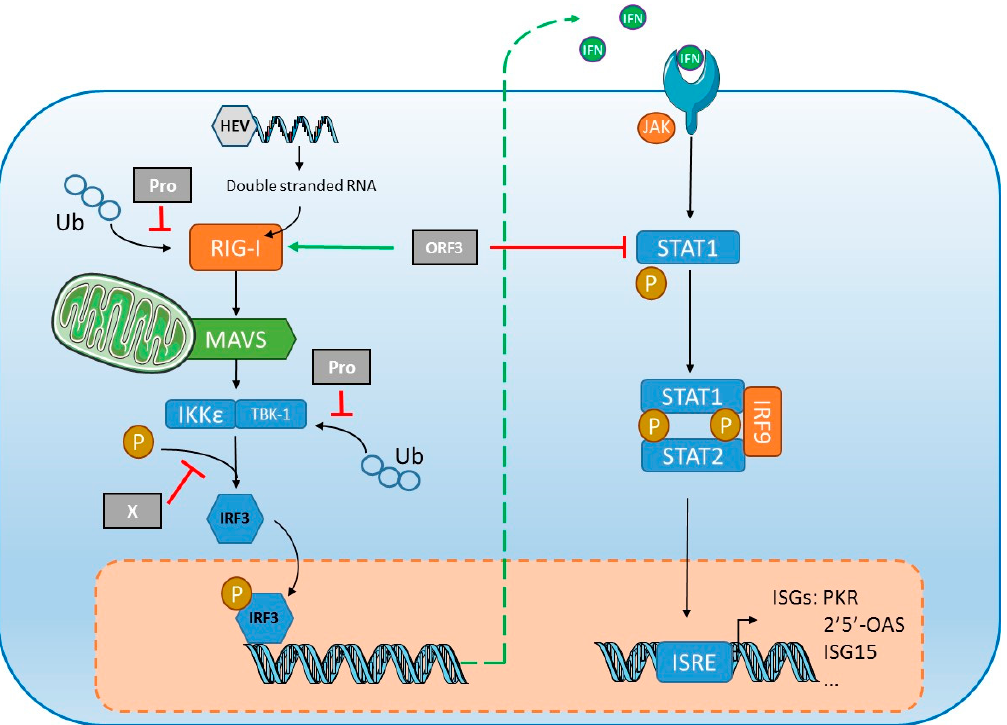
Figure 3. Interference of HEV with the innate antiviral response. HEV RNA is detected in the cytoplasm by the retinoic acid-inducible gene I (RIG-I), leading to type I and type III interferon (IFN) production. The protease domain (Pro) of the ORF1 protein inhibits signaling via RIG-I and prevents IFN induction by de-ubiquitining RIG-I and TANK binding kinase 1 (TBK-1). The X domain (X) inhibits the phosphorylation (P) of IFN regulatory protein 3 (IRF3). Conversely, the ORF3 protein stimulates the direct interaction of type I IFN with RIG-I, but ORF3 also binds to STAT1 to restrict its phosphorylation and activation of the downstream cascade, thus inhibiting the expression of the IFN-stimulated genes (ISGs), including the double stranded (ds)RNA-activated protein kinase (PKR) and 2 ′ ,5 ′ -oligoadenylate synthetase (2 ′ 5 ′ -OAS) or ISG15. IKK ε : I κ B-Kinase-epsilon; IRF9: IFN regulatory protein 9; ISRE: interferon stimulated response element; MAVS: mitochondrial antiviral-signaling protein; Ub: ubiquitin.